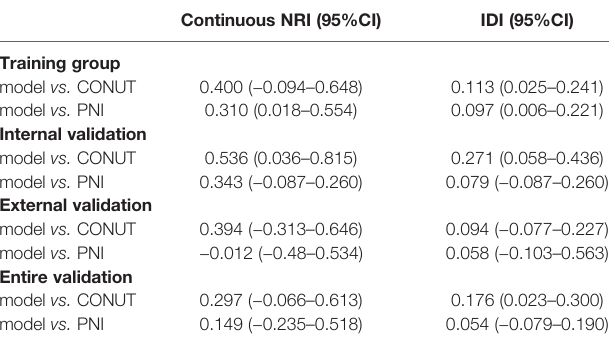
TABLE 4 | Diagnostic performance of NRI and IDI between model and CONUT/ PNI.